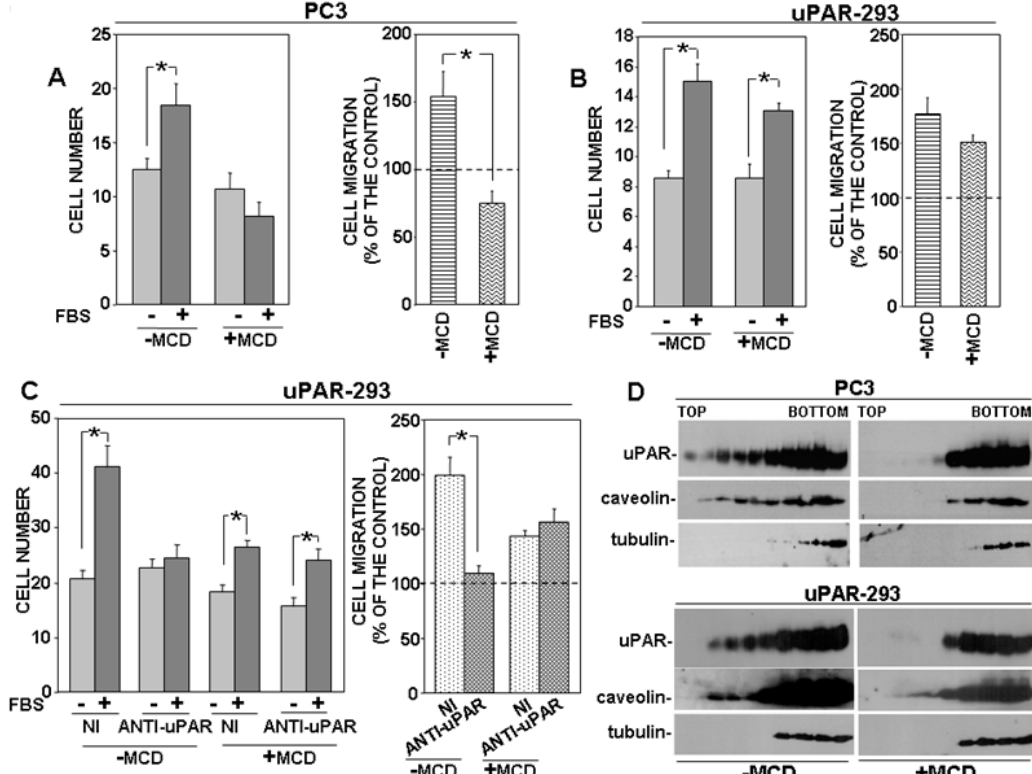
Figure 4. Disruption of lipid rafts impairs uPAR-controlled cell migration. PC3 ( A ) or uPAR-293 ( B ) cells were treated with or without 10 mM methyl-beta-cyclodextrin (MCD). Cells were then plated in Boyden chambers and allowed to migrate towards 10% fetal bovine serum (FBS). MCD treated or untreated uPAR-293 cells were also incubated with 5 µg/mL polyclonal anti-uPAR antibody or nonimmune Ig (NI) before migration ( C ). Migrated cells were fixed, stained with hematoxylin, and counted (left panels). Results of migration assays are also expressed as percentage of cells migrated towards serum over the cells migrated without serum; 100% values represent cell migration in the absence of chemoattractants (right panels). The values are the mean + SD of three experiments performed in triplicate. (*) p < 0.05, as determined by the Student’s t -test. PC3 and uPAR-293 cells treated with or without MCD were also lysed in buffer containing 1% Triton X-100. Cell lysates (1 mg) were loaded onto a sucrose density gradient and subjected to ultracentrifugation. Then, 4.5 mL were harvested as 0.45 mL fractions. Equal volumes of each fraction were analyzed by Western blot with an anti-uPAR monoclonal antibody, or with anti-tubulin or anti-caveolin antibodies, as controls of non-raft associated proteins or raft associated proteins, respectively ( D ).